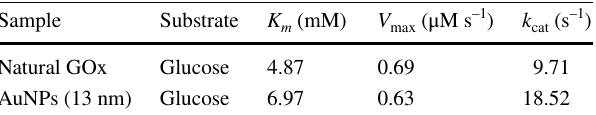
Table 2 GOx-like catalytic activities of natural GOx and AuNPs (13 nm) Sample